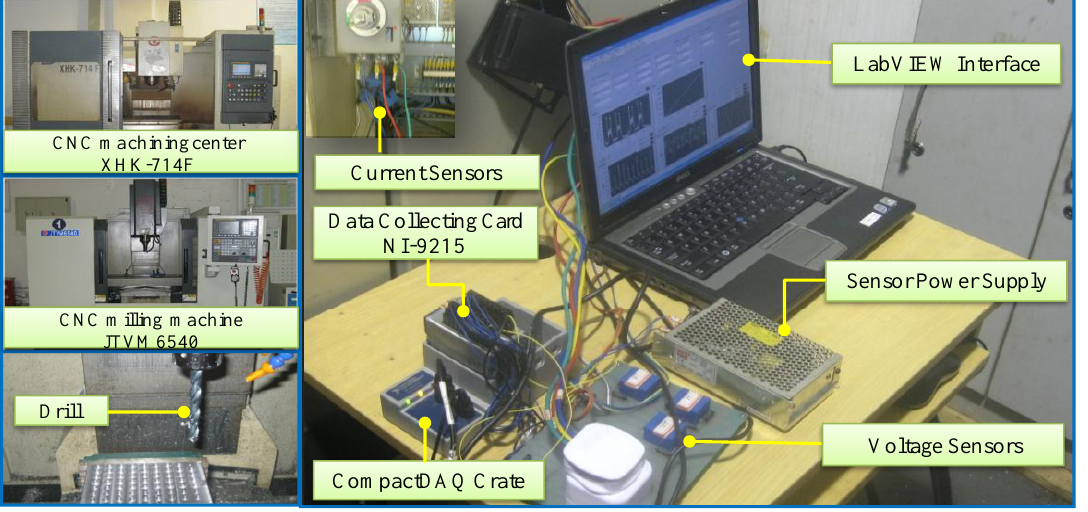
Figure 6. Experimental setup of power-energy acquisition system.